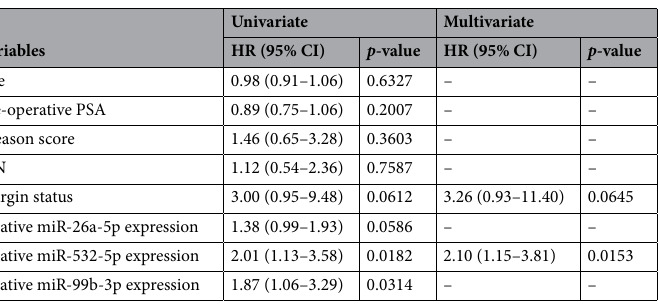
Table 3. Univariate and multivariate Cox-regression analyses of prostate cancer